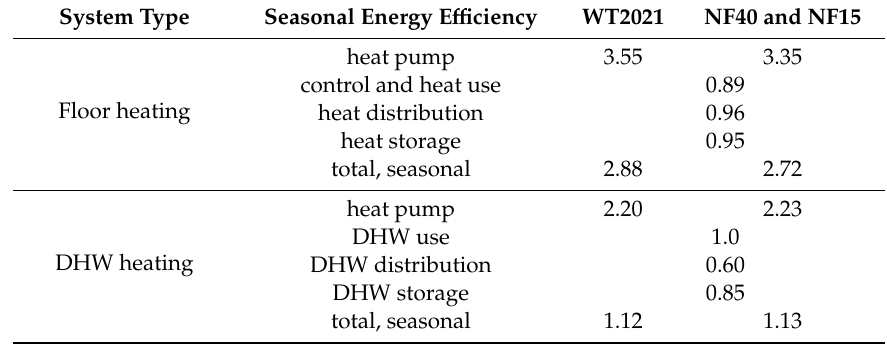
Table 9. Calculation of total energy e ffi ciency of floor and DHW heating systems with ASHP.